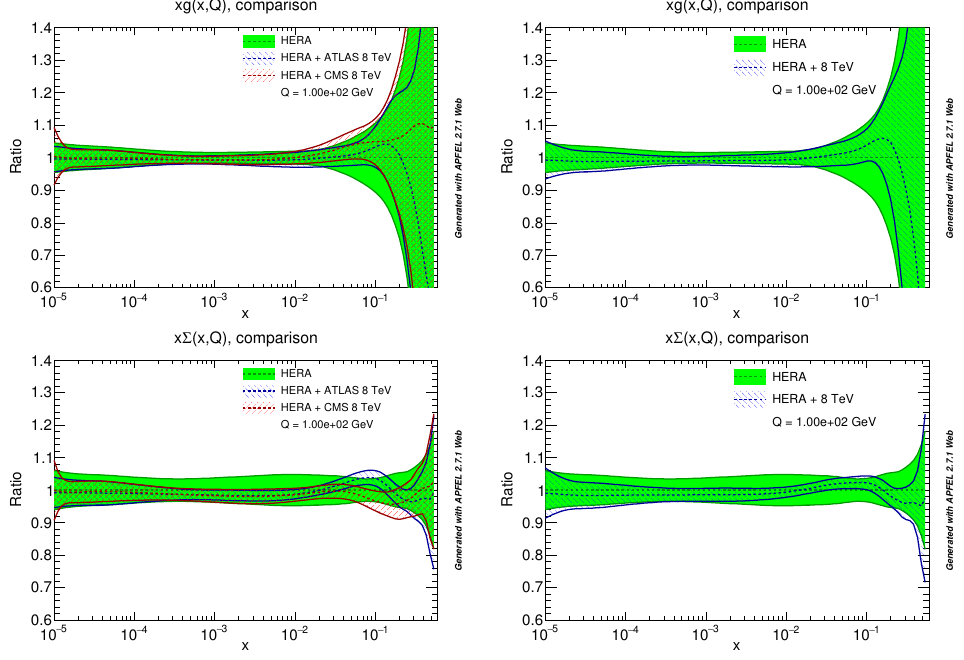
Figure 9 . Impact of the inclusion of 8 TeV p Z PDFs in a HERA-only (cid:12)t.